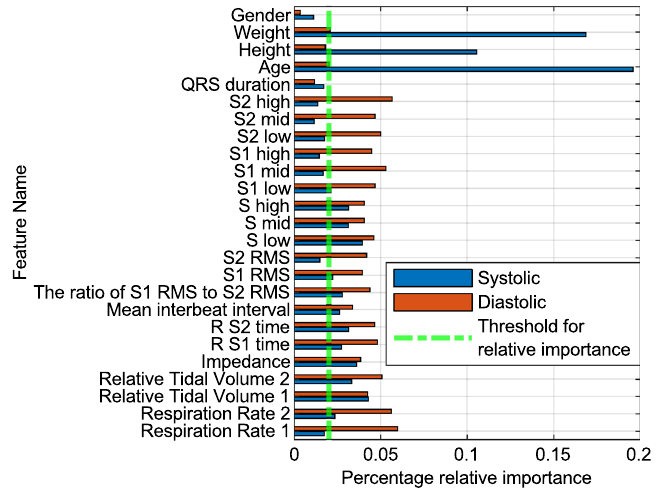
Figure 6. Relative importance of features for predicting SBP and DBP using impurity-based feature importance.